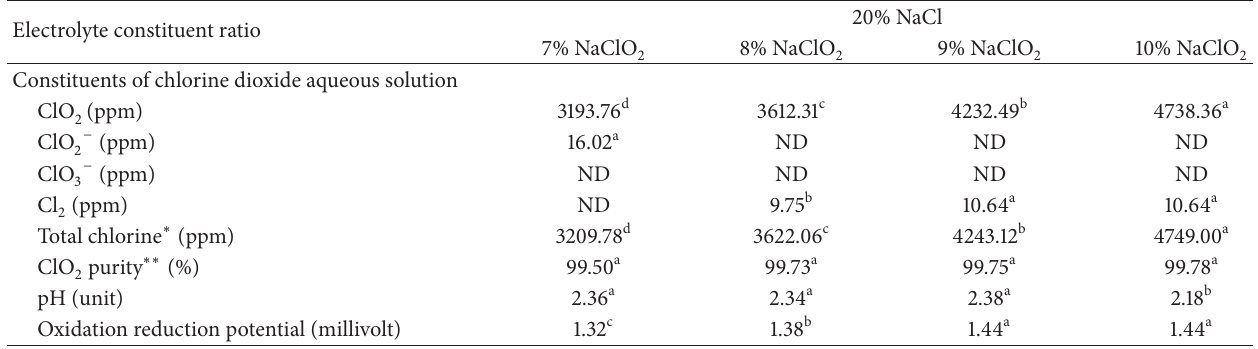
20% NaCl 7% NaClO 2